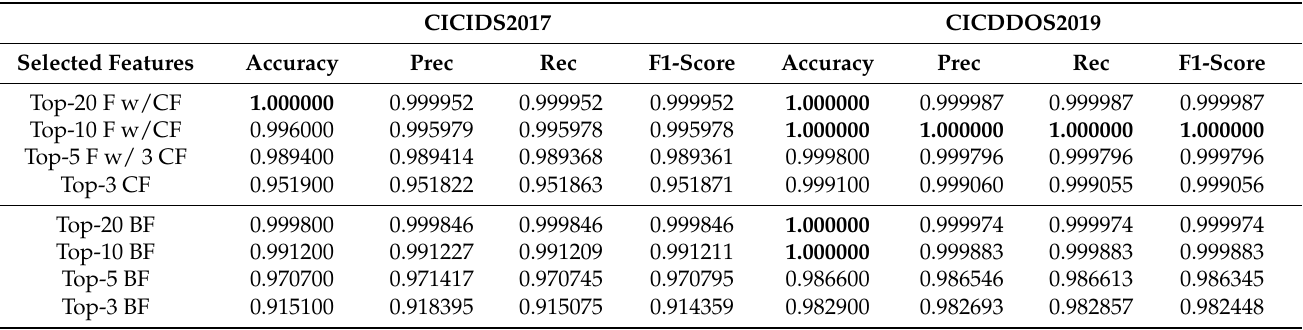
Table 1. Performance of binary classifier trained with different selected